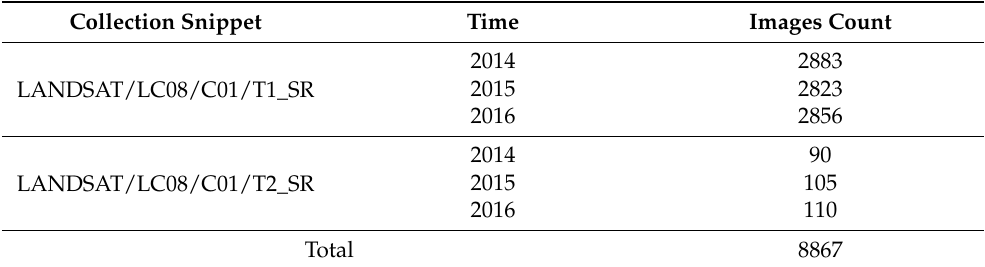
Table 3. The collection snippets and number of Landsat 8 images during the target period we used in this